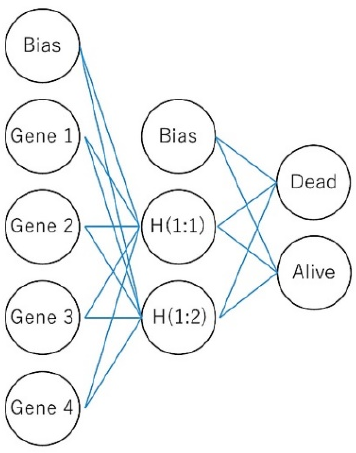
Figure 2. The basic structure of a neural network. The network is a function of predictors (also called inputs or independent variables) that minimize the prediction error of target variables (outputs). In the case of a multilayer perceptron, it is a feed-forward architecture because the connections flow from the input to the output layer without loops. Here, four genes predict the overall survival of patients. The input layer contains these genes. The hidden layer contains the unobservable nodes (units). The output layer contains the responses; the overall survival is a categorical variable (dead vs alive).